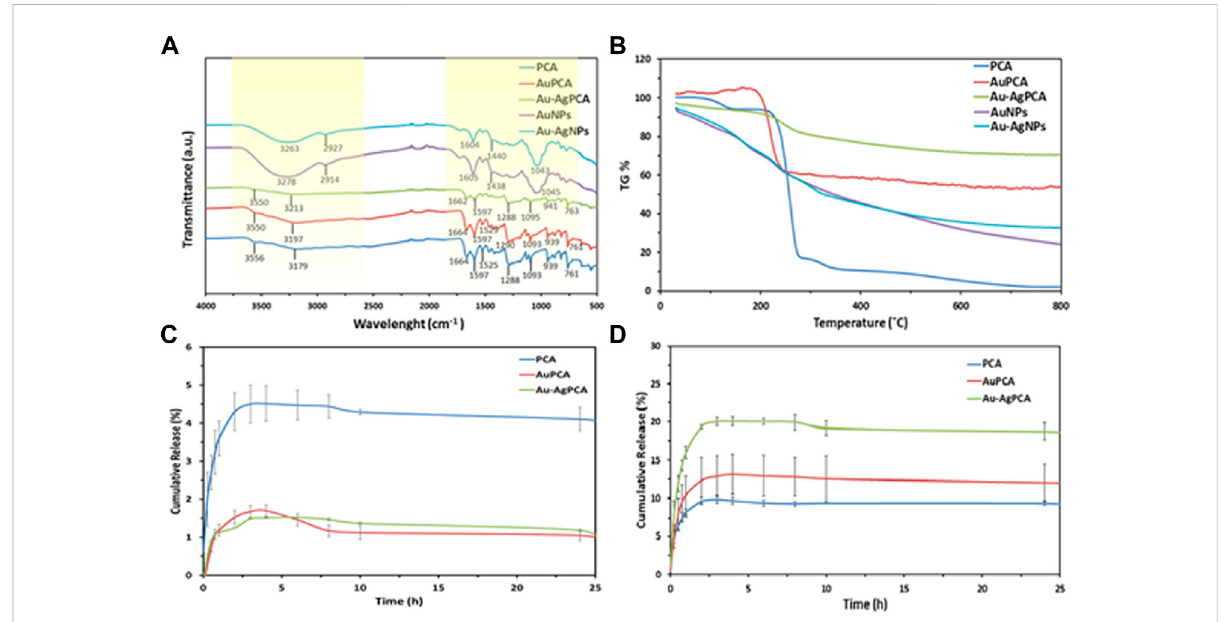
FIGURE 4 Drug loading of AuPCA and Au-AgPCA based on (A) FTIR, (B) TGA and (C) drug release of AuPCA and Au-AgPCA at pH 7 and (D) pH